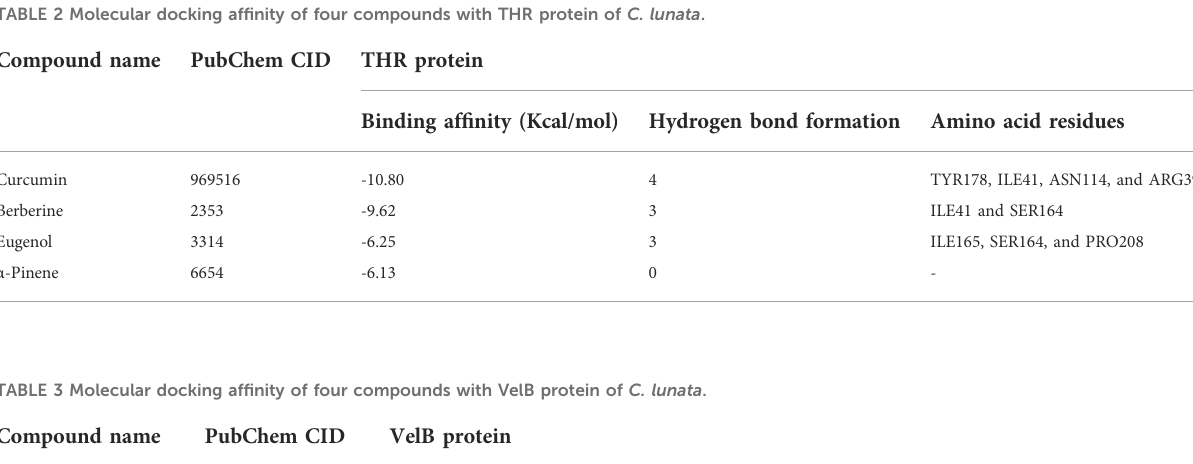
TABLE 2 Molecular docking af fi nity of four compounds with THR protein of C. lunata .